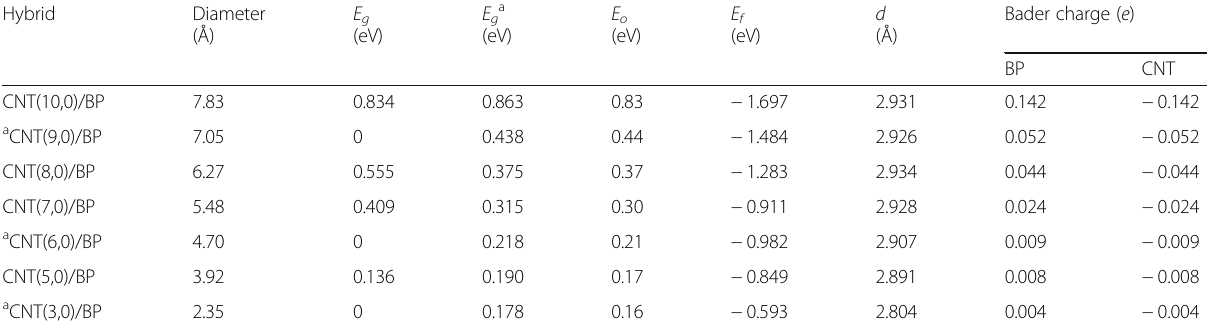
Table 1 The diameter, band gap E g of pure CNTs and the formation energy ( E f ), band gap E g * , optical gap E o , and interfacial spacing ( d ) of optimized CNT/BP composites